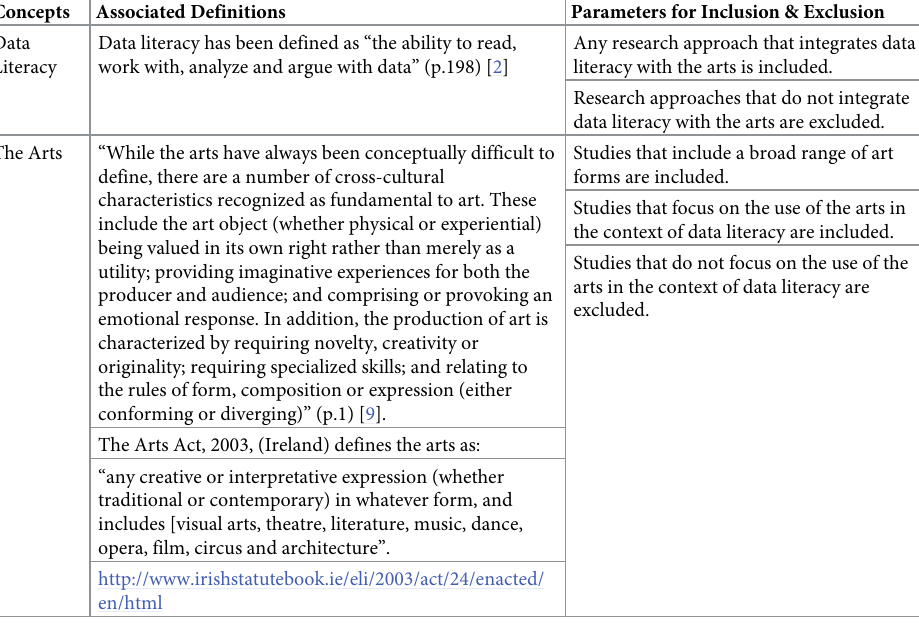
Table 1. Concepts, definitions and boundaries of the research